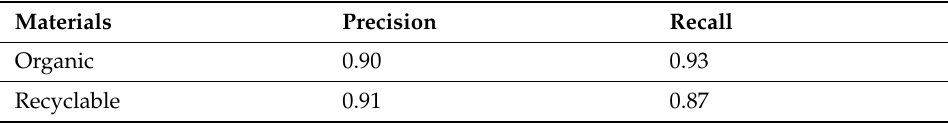
Figure 8. Confusion matrix of the proposed model. Table 7. Precision and recall table.